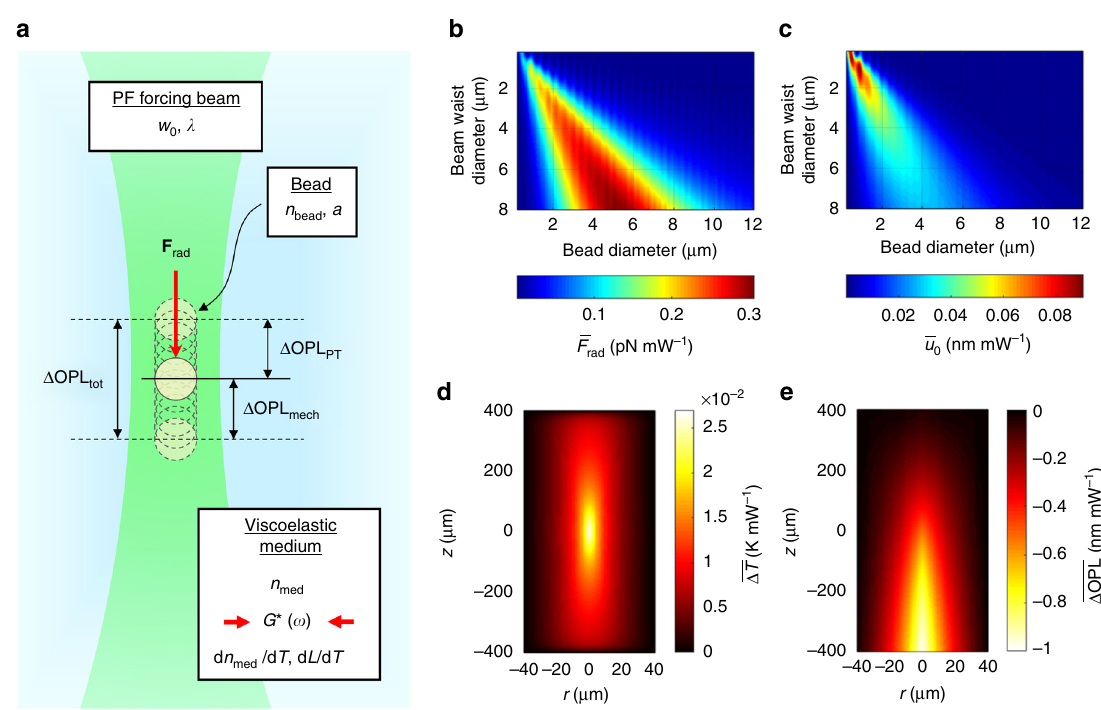
Fig. 1 Underlying principle of PF-OCE and theoretical prediction of bead responses. a Cartoon illustration of the working principle of PF-OCE depicting mechanical excitation by modulated radiation-pressure force, F rad , from a low-NA beam and various factors, associated with the PF forcing beam, the bead, and the viscoelastic medium, that affect the measurement of change in OPL. b Magnitude of normalized forward radiation-pressure force, F Gaussian beam ( λ = 976 nm) on a non-absorbing spherical bead embedded in a medium (refractive indices n bead = 1.58 and n med = 1.34) as a function of bead diameter, 2 a , and beam waist diameter, 2 w 0 , obtained from simulation based on generalized Lorenz-Mie theory (GLMT). c Normalized (physical) bead oscillation amplitude, u 0 , resulting from harmonically modulated radiation-pressure force with peak amplitude F (20 Hz) for a viscoelastic medium with G* ( ω ) = 250 + 4 i (Pa). d Map of normalized change in temperature, Δ T , of an aqueous medium after 50 ms of exposure to a Gaussian beam ( λ = 976 nm, w 0 = 3.19 μ m). e Map of cumulative optical path length change, Δ OPL , induced by Δ T based on a PT-OCT model (Supplementary Methods). Note that ( e ) represents OPL and not physical distance. In ( d ) and ( e ), r and z denote the radial and axial (depth) coordinates, de fi ned w.r.t. the focus of the beam,